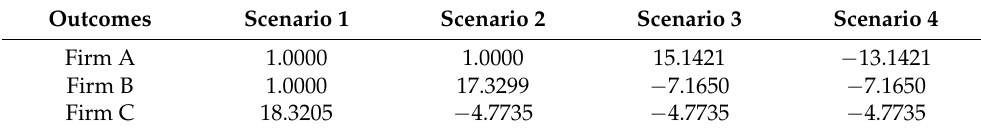
Table 2. Periodic liquidity shock outcomes.